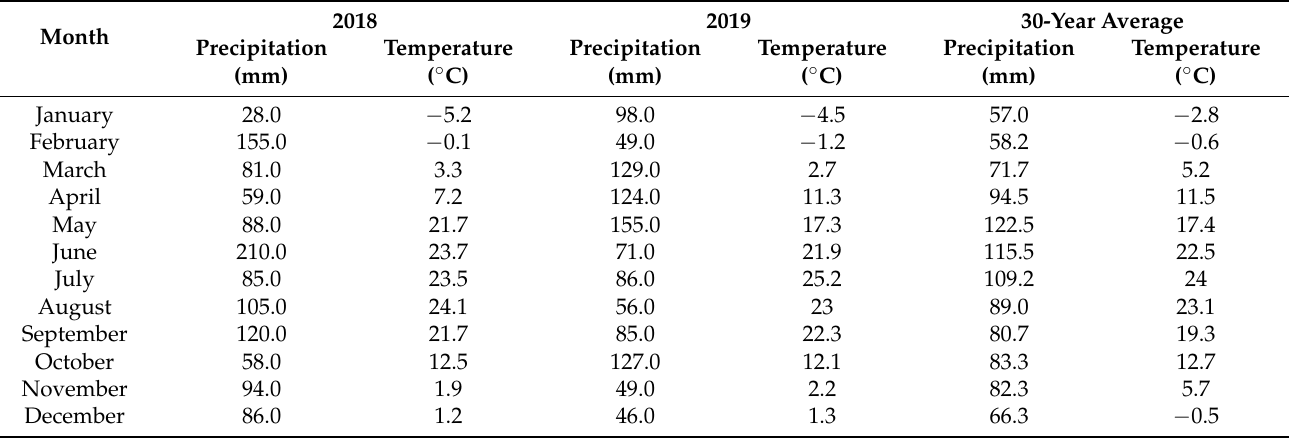
Table 3. Monthly precipitation and maximum, minimum, and average temperatures in 2018 and 2019 in Urbana, IL, USA. The weather data were obtained from National Oceanic and Atmospheric Administration (NOAA) at Willard Airport Station.